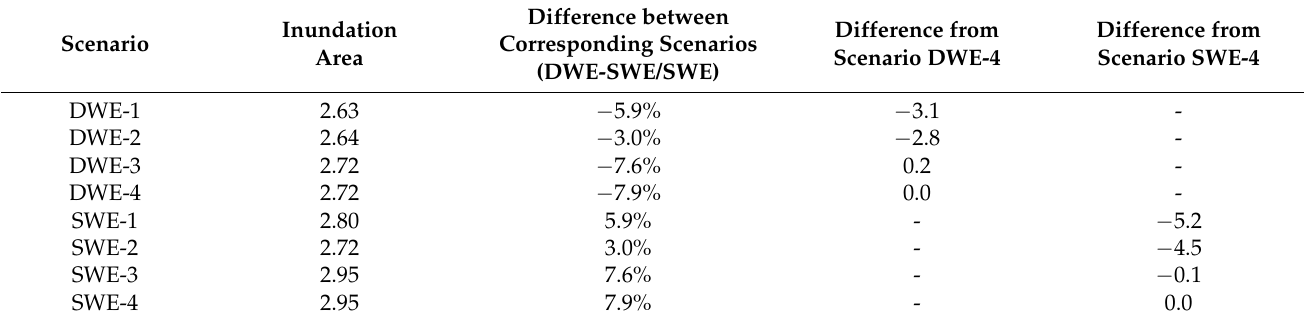
Table 2. Extent of the total inundation area (km 2 ) and differences between various scenarios (%).